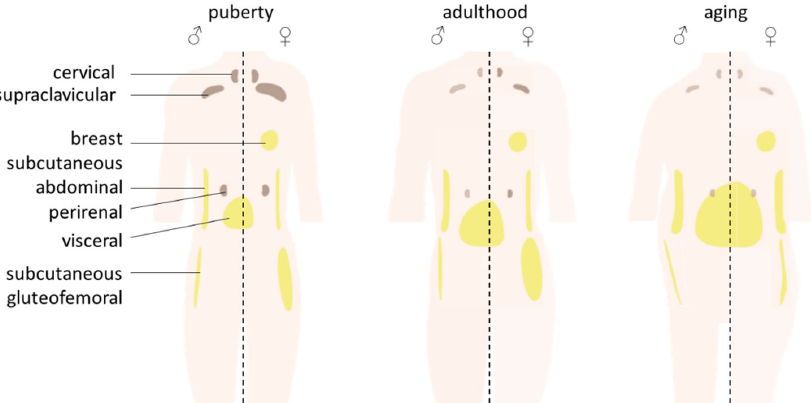
Figure 2. Evolution of the distribution of white and brown fat depots in men and women.Distribution of WAT (yellow) and BAT (brown) fat depots in men ( left ) and women ( right ) at puberty, adulthood and aging. Already at puberty, men exhibit more truncal fat (visceral and subcutaneous abdominal AT) while women have more subcutaneous gluteofemoral fat and supraclavicular BAT. During adulthood, the differences in WAT distribution are exacerbated. With aging in both men and women, the ratio of visceral over subcutaneous AT increases. BAT depots decrease all life long, with a higher impact in men than women.